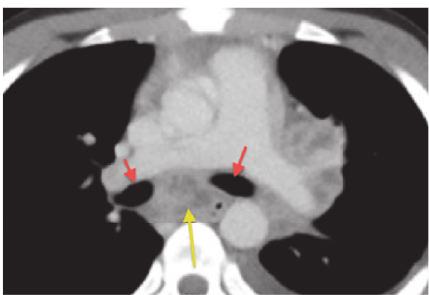
Figure 1: Diffuse infiltrations of the left upper lung/mediastinal abscesses.